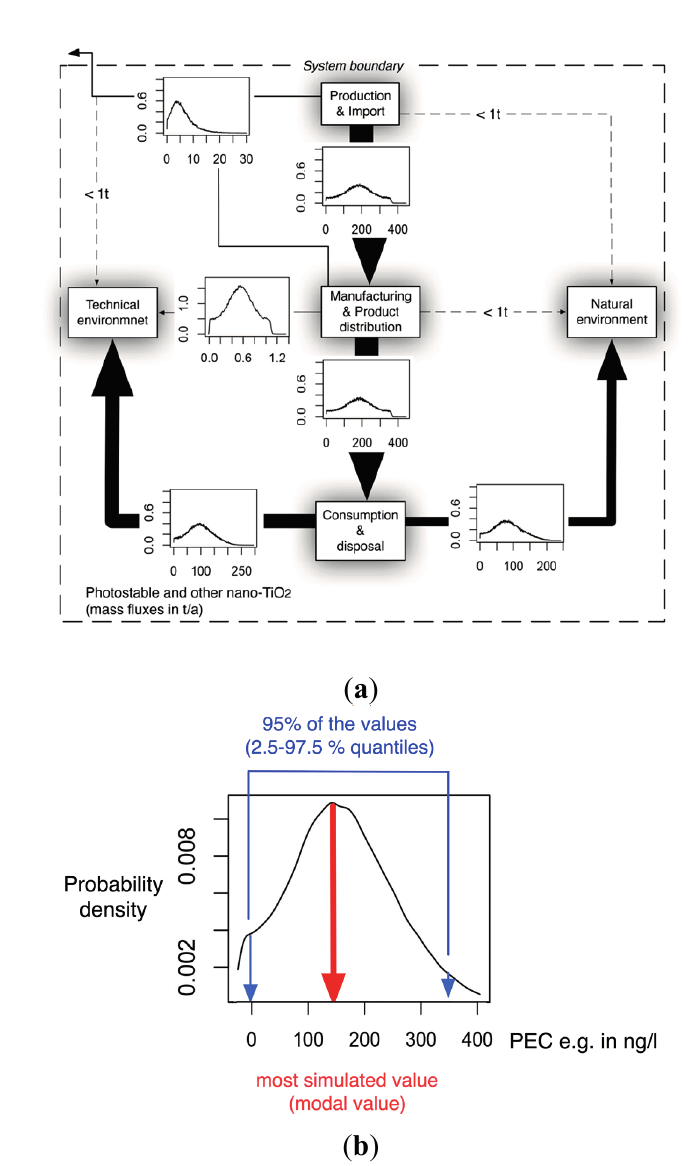
Figure 1. ( a ) Exemplary mass transfer flows in Denmark for nano-TiO 2 , showing the total ENM transport between natural and technical systems. (b) : probability distribution with the modal value (red) and the 95% interval (blue) that is given in the results